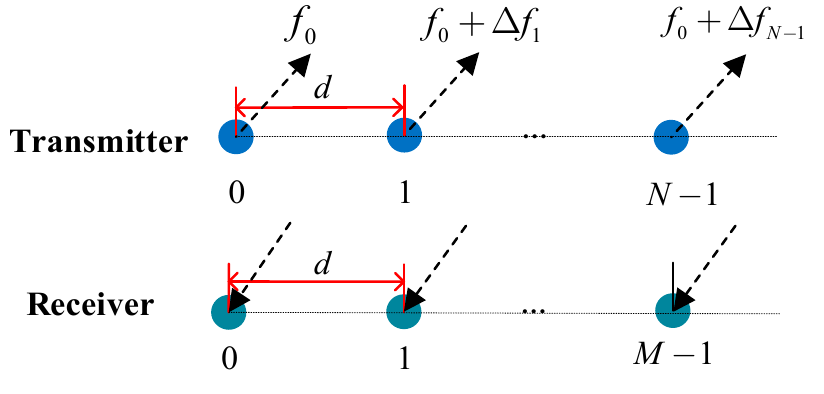
Figure 1. The FDA-MIMO array structure.